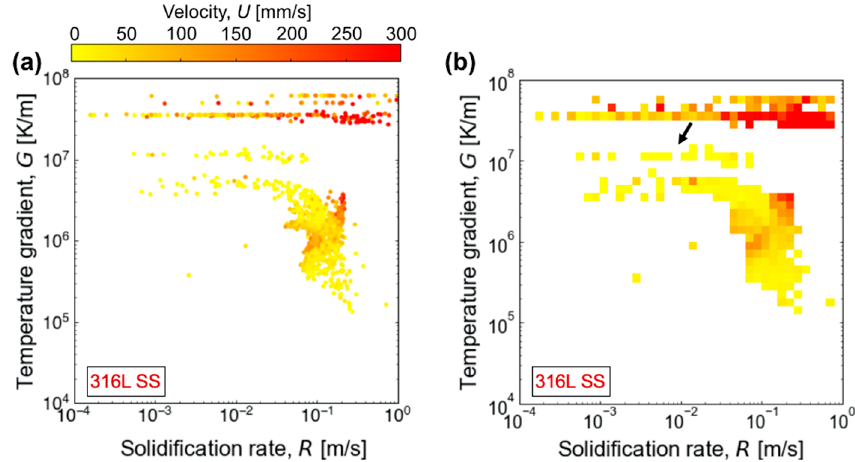
Figure 12. ( a ) G – R plot of 316L SS colored by a fluid velocity. ( b ) The average fluid velocity of 316L SS calculated for each mesh of the double logarithmic grid using the points of solidification condition within each mesh.